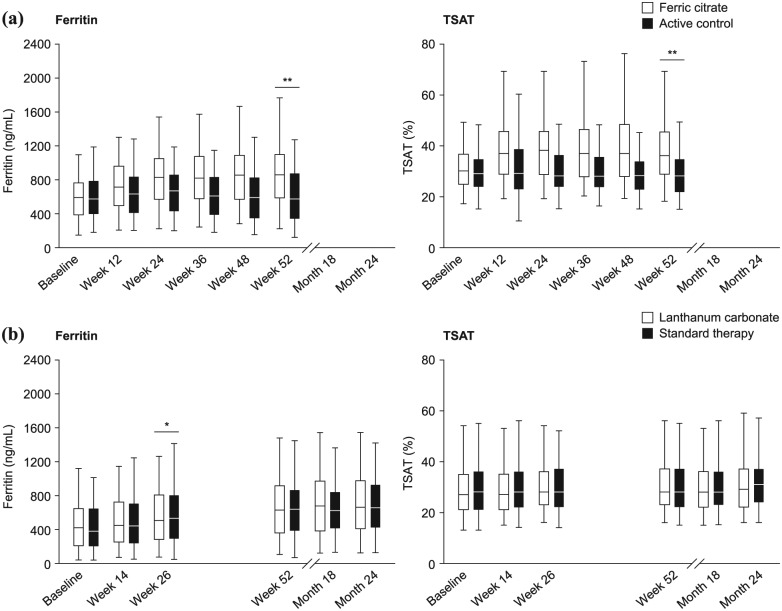
Changes in ferritin and TSAT levels over (a) 52 weeks of treatment with ferric citrate9 and (b) 24 months of treatment with lanthanum carbonate (study SPD405-307).Source: Panel (a) adapted with permission from the Journal of the American Society of Nephrology by the American Society of Nephrology, from Lewis et al.9 Copyright© 2015; permission conveyed through the Copyright Clearance Centre.TSAT: transferrin saturation.Data are presented as the 5th, 25th, median, 75th and 95th percentiles. (a) All p values were only available for 52-week comparisons between the treatment arms (**p < 0.001). (b) All post-baseline comparisons between the treatment arms were non-significant (p > 0.05), except for serum ferritin levels at week 26 (*p = 0.004).